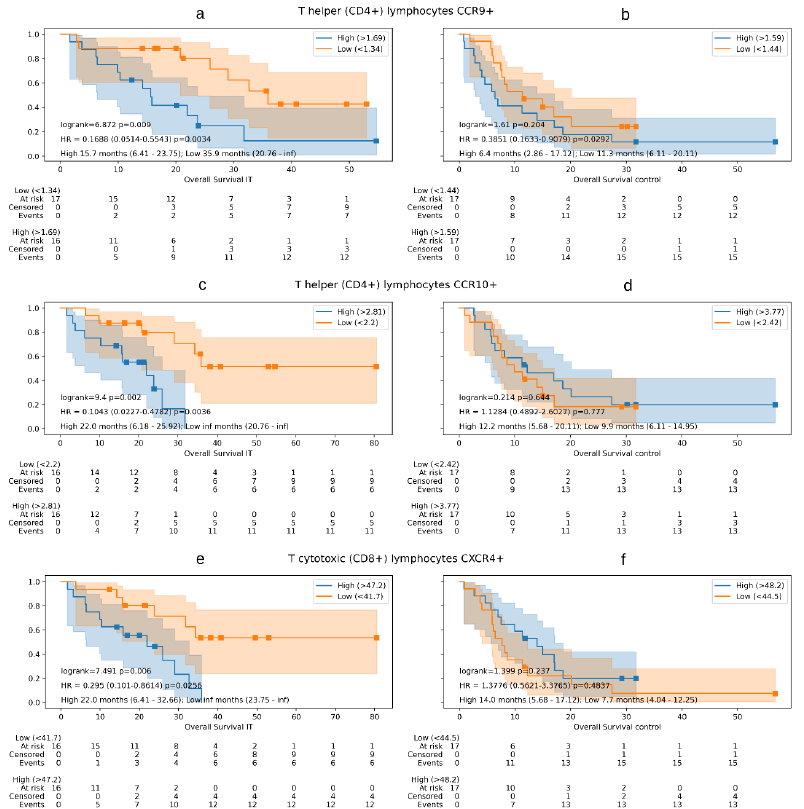
Figure 1. Overall survival Kaplan–Meier curves showing overall survival differences between immunotherapy treatment (IT) study group versus control group. The Kaplan–Meier curves show the differences in survival according the high or low expression of each peripheral blood mononuclear cell subpopulation studied in both groups. In addition, the log-rank test, multivariate cox regression models, and the median overall survival values with their range are reflected. Graphics ( a , b ) show overall survival in immunotherapy treatment group ( a ) versus study group ( b ) according to the expression of T-helper lymphocytes CCR9+. Graphics ( c , d ) show overall survival in immunotherapy treatment group ( c ) versus study group ( d ) according to the expression of T-helper lymphocytes CCR10+. Graphics ( e , f ) show overall survival in immunotherapy treatment group ( e ) versus study group ( f ) according to the expression of T-cytotoxic lymphocytes